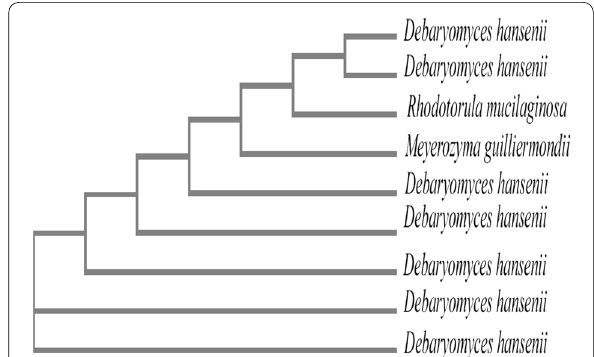
Fig. 1 Endophytic yeasts identified on the basis of 18S rDNA sequencing showing their ancestral relationship. Phylogenetic tree was generated using parsimony, neighbor‑joining and maximum likelihood analysis of aligned sequences with different sets of